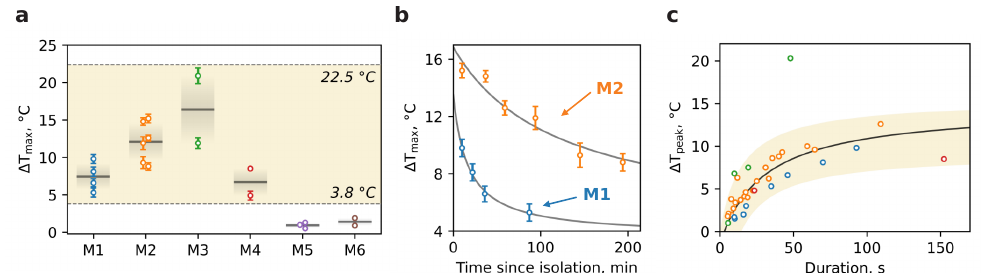
Figure 4. Statistics and kinetics of thermal responses per mice. ( a ) Maximal thermal response ∆ T max for a variety of mice. The gray lines indicate the mean value over dishes for selected mice; the same color gradients extend the standard deviation. The vertical dashed line separates two groups of mitochondria: M1–M4 in the glucose-containing medium and M5–M6 in the glucose-free one. ( b ) Time evolution of ∆ T max for mice M1 and M2. Gray solid lines are added for visual purposes. ( c ) The amplitude of thermal bursts ∆ T peak collected from temperature traces as a function of their duration. Note that ∆ T peak takes into account the background baseline humpback. Experimental points were fitted with black